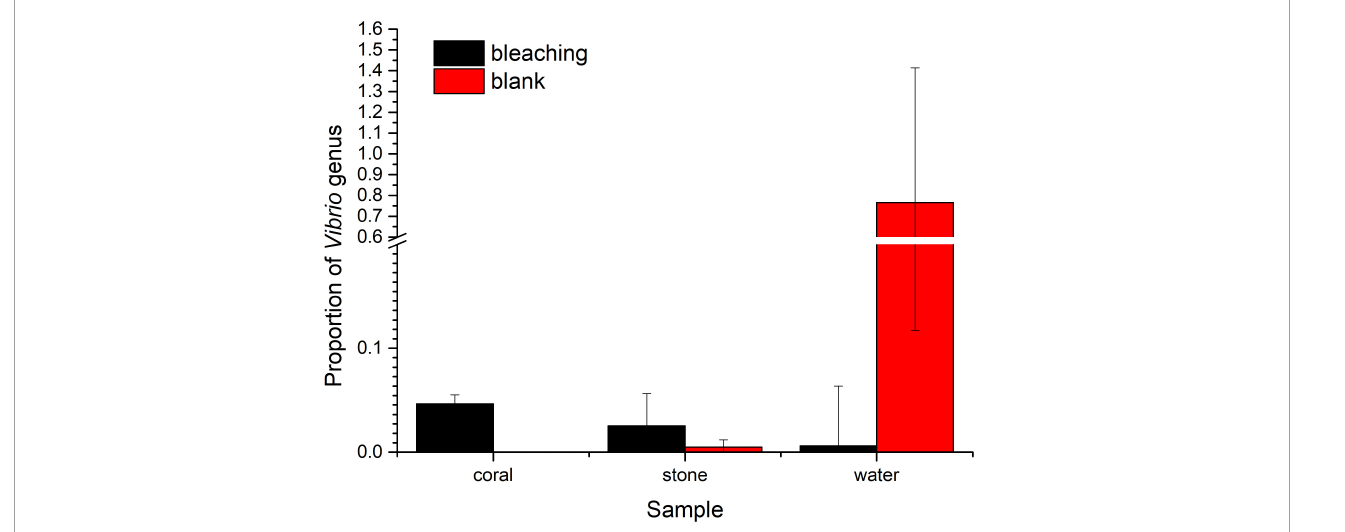
FIGURE8 Proportion of Vibrios in each fraction of coral culture system. The taxonomy of each OTU representative sequence from the high-throughput sequencing result was analyzed by RDP classifier version 2.2 and classified on genus level. The proportion of the OTUs representing the Vibrio genus is presented in bar charts, where the samples in the blank group are presented in red, and those in S10-1-infected groups are presented in black. The error bars indicate the value of standard